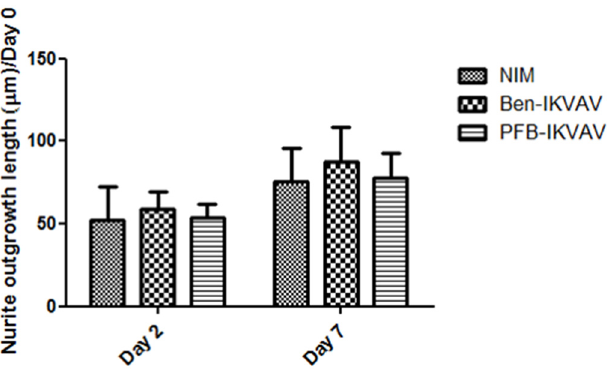
Figure 8. Neurite outgrowth lengths of hMSCs cultured with NIM (control), Ben-IKVAV in NIM, and PFB-IKVAV in NIM for 2 days and 7 days ( n = 50).